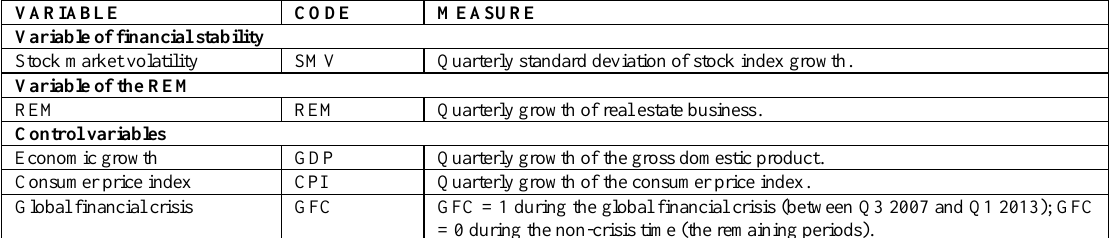
Table 1. Summary of the variables